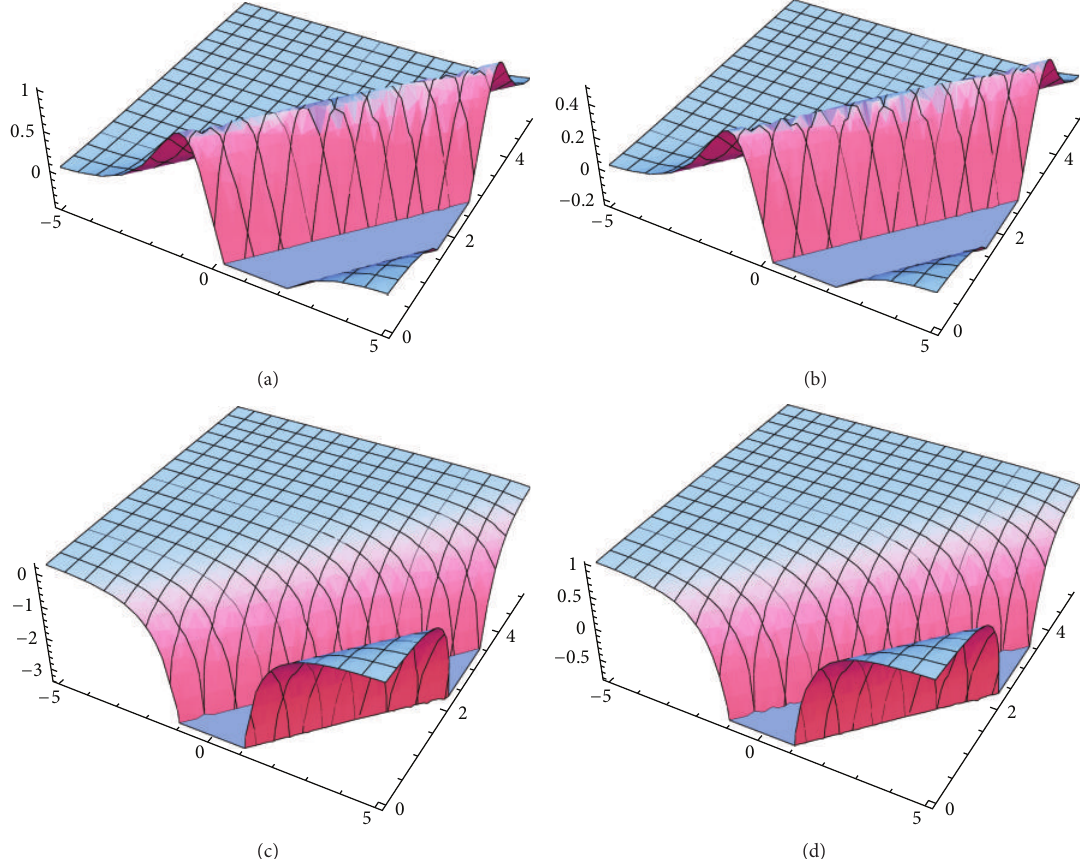
Figure 4: Graph of the solutions 𝑢(𝑥,𝑡) and V (𝑥,𝑡) corresponding to the value 𝑏 0 = 1 from left to the right for (25) and